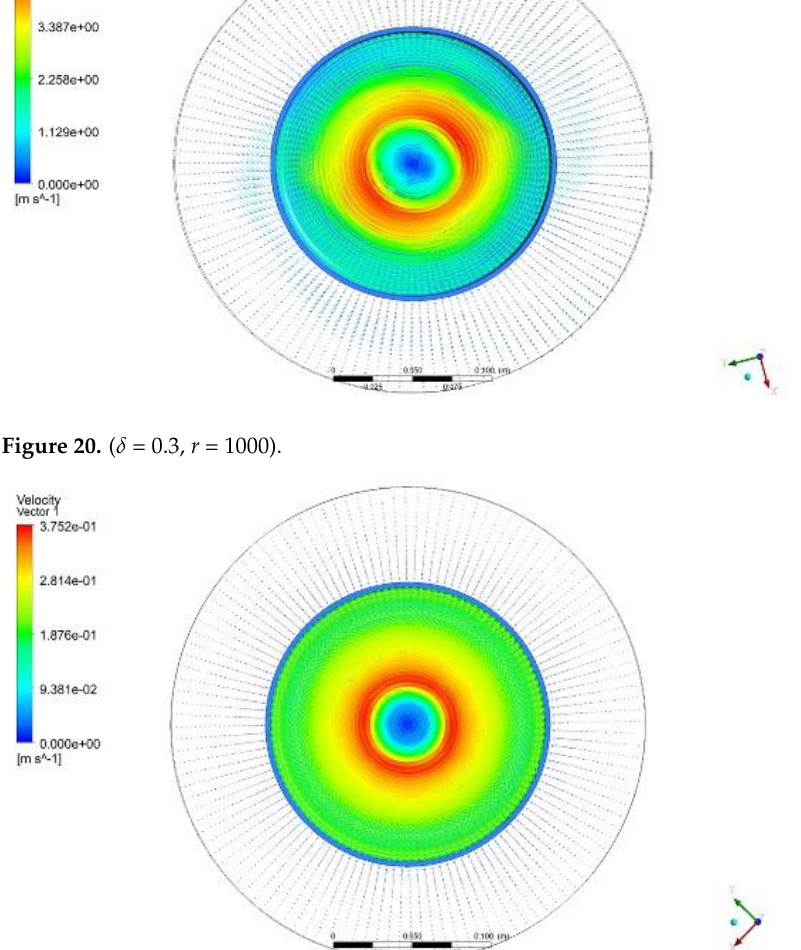
Figure 21. ( δ = 0.3, r =